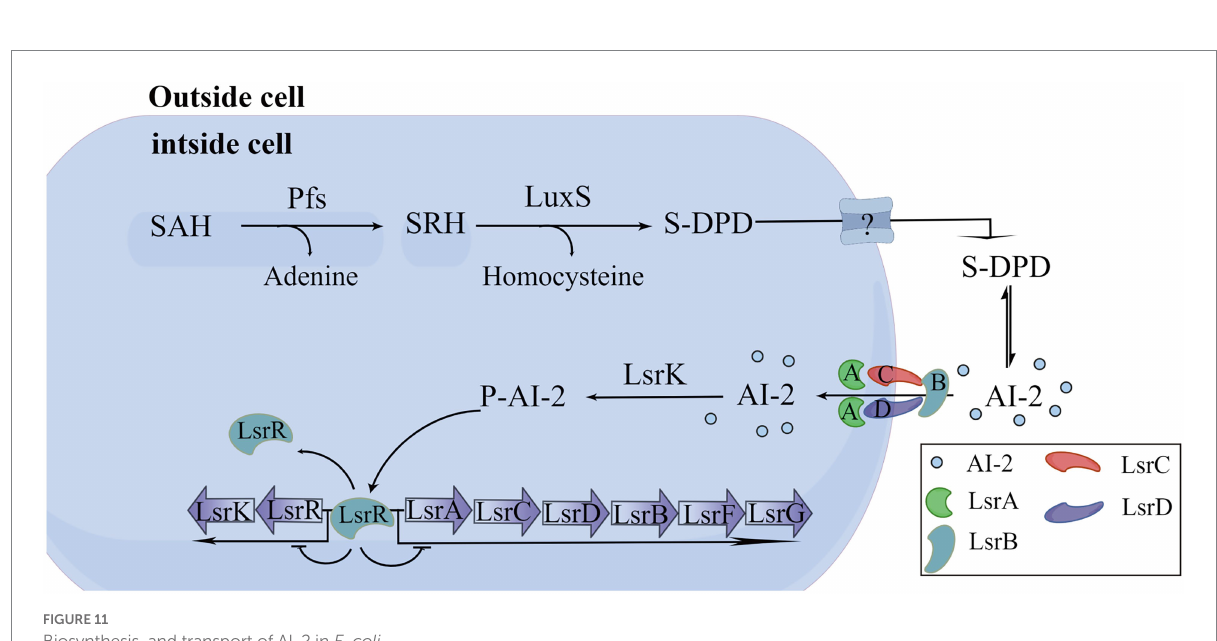
FIGURE 11 Biosynthesis, and transport of AI-2 in E. coli